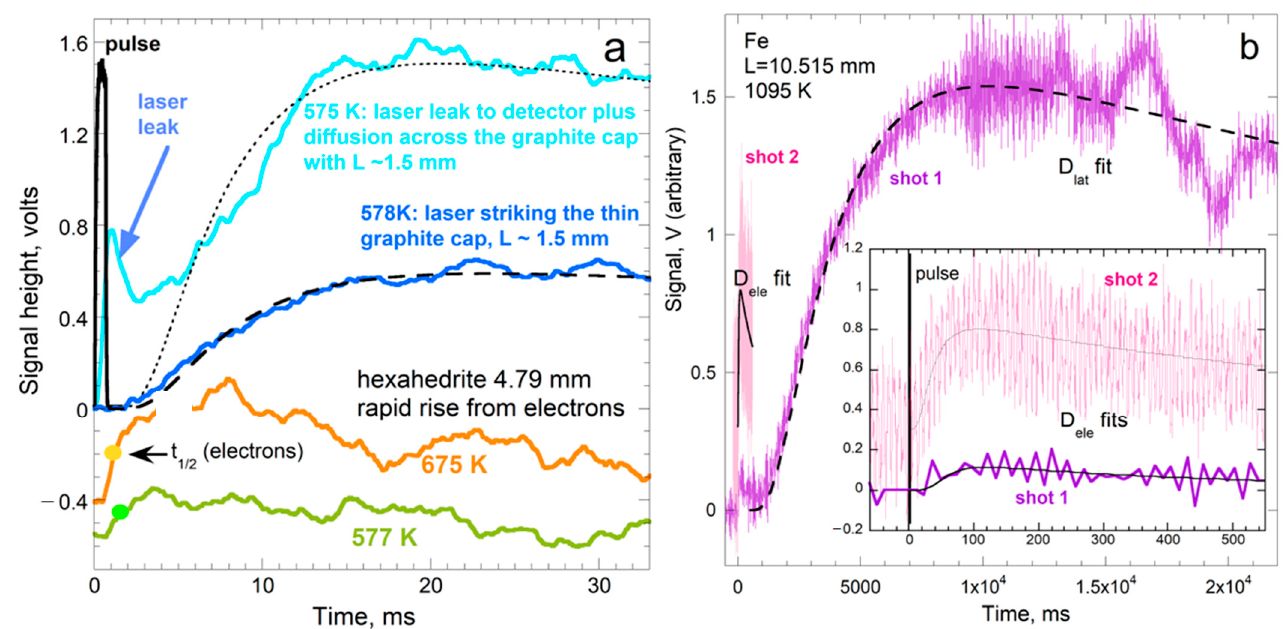
Figure 3. Temperature–time curves revealing fast electronic transport: ( a ) Raw data collected over a short time from a Fe-Ni meteorite with L = 4.59 mm at moderate T . Blue curves from [9], which is open access, used a holder and cap with apertures permitting laser light to reach the detector and/or to directly heat the thin graphite cap. Orange and green curves, offset for clarity, record emissions only from the meteorite and show electronic heat transport. ( b ) Long sample of electrolytic iron at high T . Purple curve shows a long duration where the sample is first heated by electrons, then cools radiatively to the surroundings, and next warms by vibrational transport. Long durations provide instabilities at long times. Both electronic T - t (inset) and vibrational evolution are fit to Cowan’s model. Pink curve shows data collected over a brief duration. Software used a large gain to meet a 1 Volt minimum signal strength, producing white noise. For long durations, wide spacing of points (inset) also produces noise. Similar D ele was obtained in [9] for other metals using short and long durations.